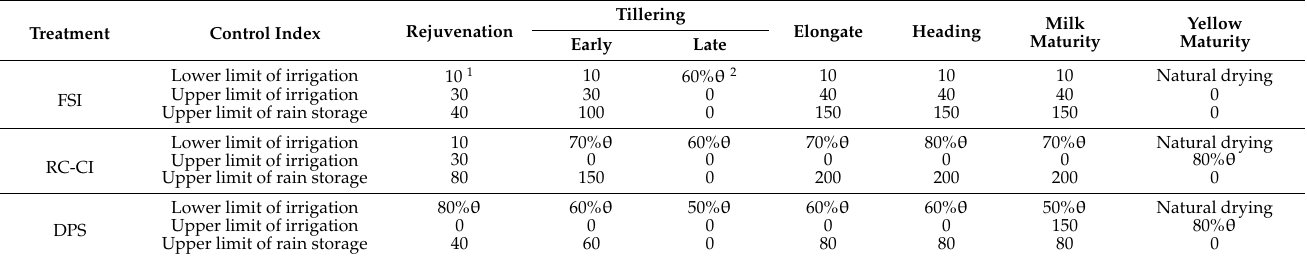
Table 2. Irrigation and drainage standards for different irrigation and drainage modes.